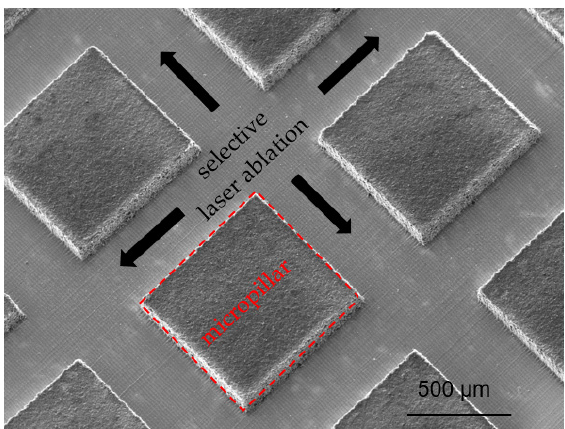
Figure 1. Scanning electron microscopy (SEM) image of a laser-generated model electrode with micropillar structures (800 µm × 800 µm).